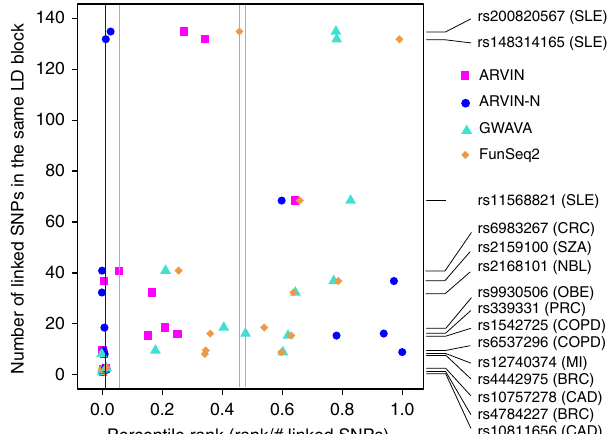
Fig. 3 Performance benchmarking using known risk SNPs located in enhancers. References for validated risk enhancer SNPs are provided in Supplementary Table 4. Y -axis represents the number of linked eSNPs in the same LD block as the known risk SNP(s). Performance is expressed as percentile ranking on the x -axis in which each gold-standard risk SNP was ranked against all other SNPs in the same linkage equilibrium block as the gold-standard SNP. Filled symbols, rank of an individual gold-standard SNP by a given method. Vertical lines, median rank of the full set of gold- standard SNPs by a given method. SNP IDs and associated diseases are shown on the right. SLE, systemic lupus erythematosus; PSO, psoriasis; CRC, colorectal cancer; PRC, prostate cancer; RA, rheumatoid arthritis; OBE, obesity; MI, myocardial infarction; BRC, breast cancer; COPD, chronic obstructive pulmonary disease; SZA, schizophrenia; CAD, coronary artery disease; NBL, neuroblastoma